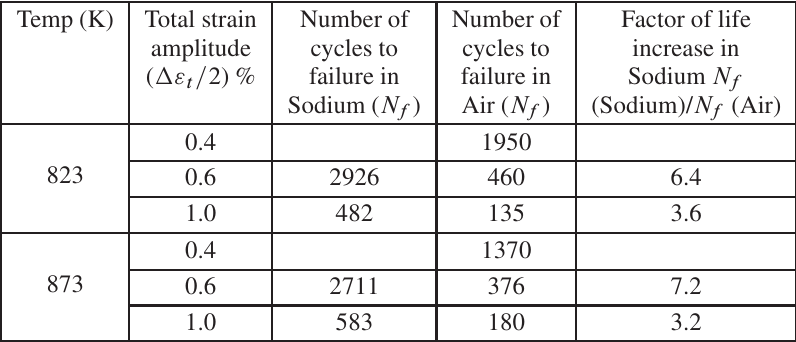
Table 3. LCF properties of 316L(N) weld joints in Sodium and Air Environment.